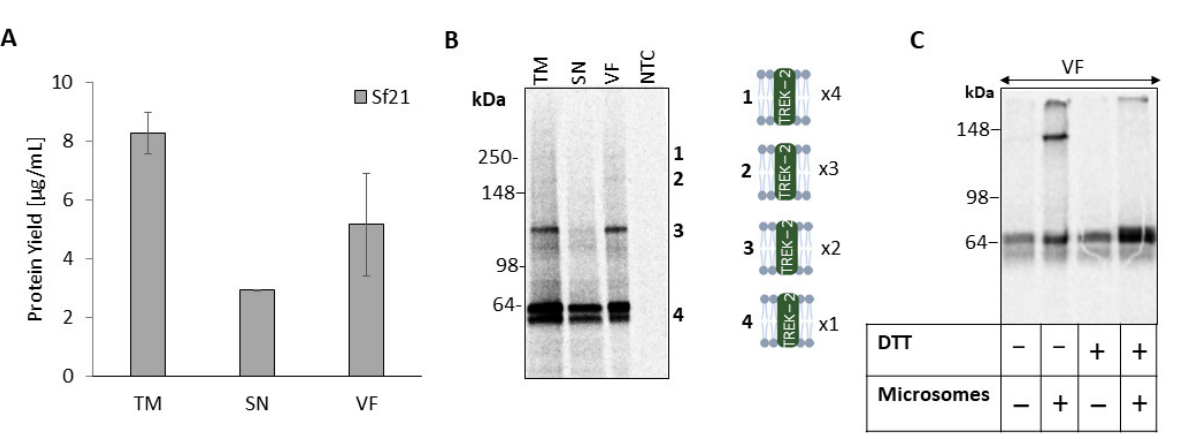
Figure 1. Cell-free synthesis of TREK-2 in Sf 21-lysate. TREK-2 was synthesized in Sf 21 lysate and 14 C labeled. The translation mixture (TM) was fractionated after synthesis by centrifugation in the supernatant (SN) and the vesicular fraction (VF). ( A ) Quantitative analysis was performed by liquid scintillation counting of synthesized TREK-2. Standard deviations were calculated from triplicates. ( B ) Autoradiogram of fractions depicting protein bands of TREK-2 by a non-denatured SDS–PAGE (4–12% Tris-Glycine). A no-template control (NTC) was used as a negative control. ( C ) Autoradiogram of VF synthesized in microsome-containing or -depleted lysate. After synthesis, samples were either reduced (supplemented with dithiothreitol (DTT)) or non-reduced applied to SDS–PAGE (10% Tris–Glycine).